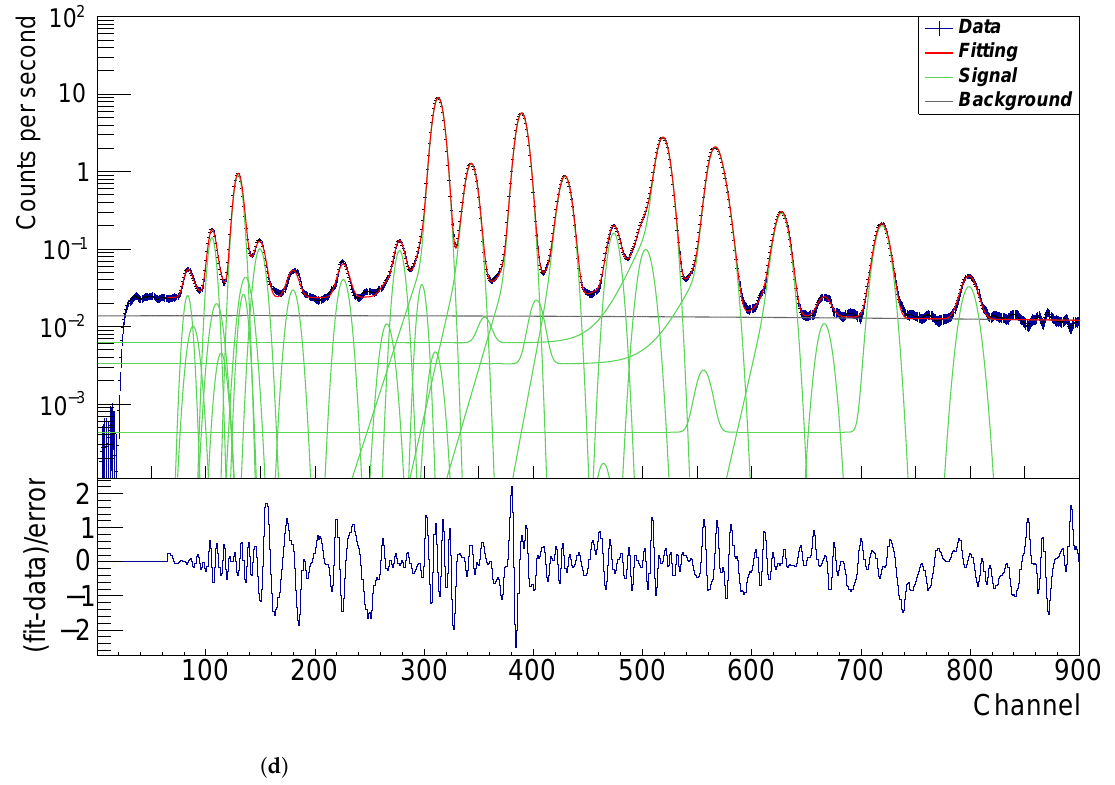
Figure 6. Spectra fitting of soil samples and calibration target are shown in the upper part of each panel: ( a ) soil sample LS1_1, ( b ) soil sample LS1_2, ( c ) calibration target, ( d ) soil sample LS2. The horizontal axis is the channel number. The vertical axis is the counts per second. The red line indicates the total fitting. The green lines indicate the signal (detector response) functions. The gray line indicates the background. The corresponding residuals of the fit, defined by the ratio of the difference between the fitting result and measurement data to measurement error, are plotted in the bottom part of each